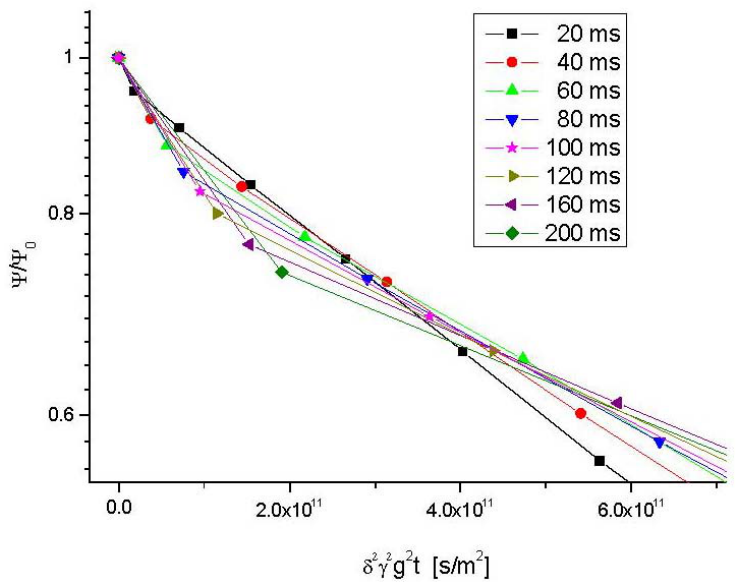
Figure 4. Scale-up of the beginning of the PFG NMR attenuation curves for propane in NaCa-LTA-0 at 25 °C as shown in Figure 3 for elaborating the distinction between the first fast and the second, more slowly decaying part of the attenuation curve. The second, more slowly decaying part of the attenuation curve originates from those molecules which, during time t , have remained in the interior of one